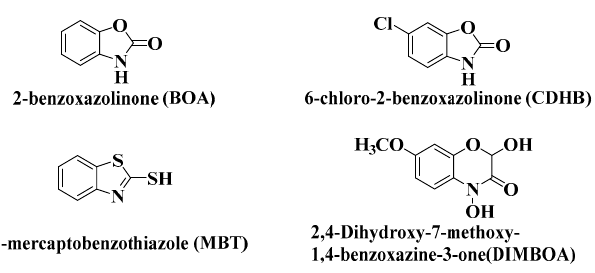
Figure 1. The structure of DIMBOA and its derivatives.